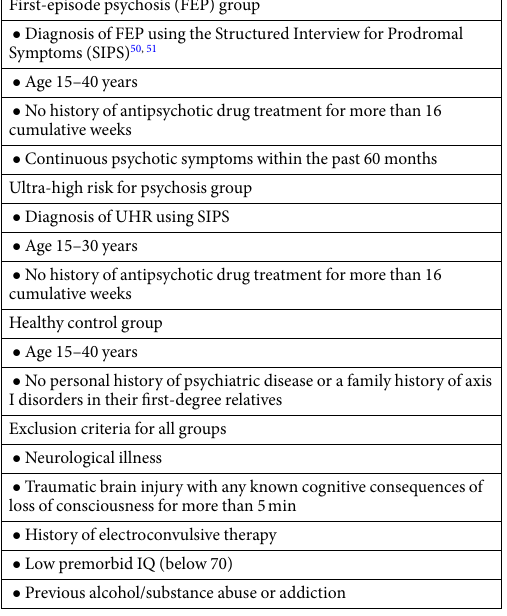
Table 2. Inclusion and exclusion criteria. Abbreviations: IQ, intelligence